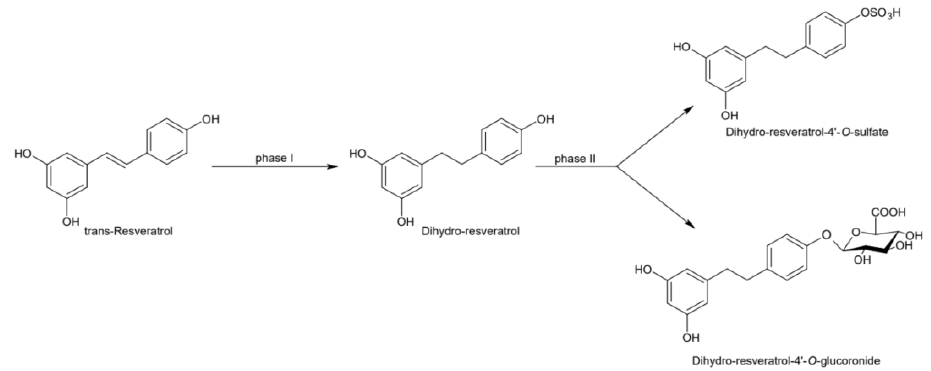
Figure 5. Microbial reduction of trans -resveratrol and conjugation of its main metabolite dihydro- resveratrol.